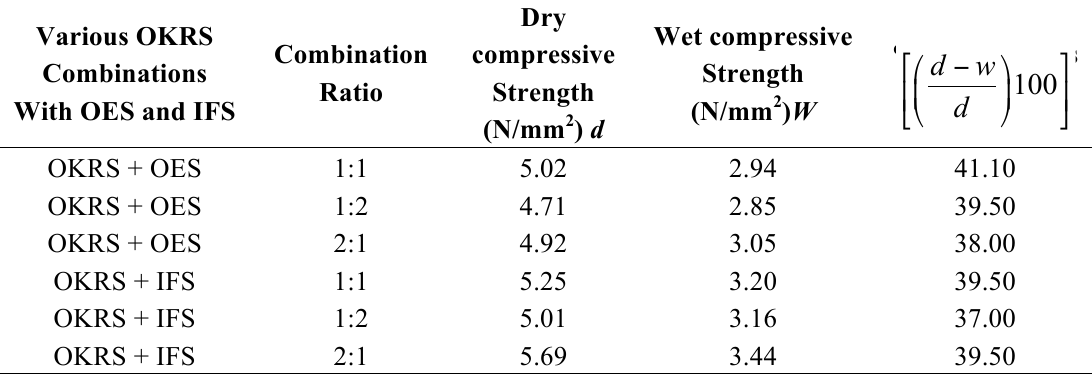
Table 6. Various OKRS combinations with OES, IFS and their wet and dry compressive strengths and percentage strength losses.